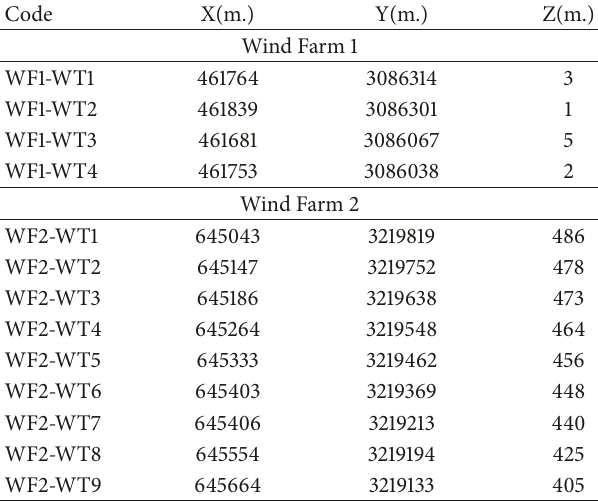
Table 1: Geographic coordinates of the wind